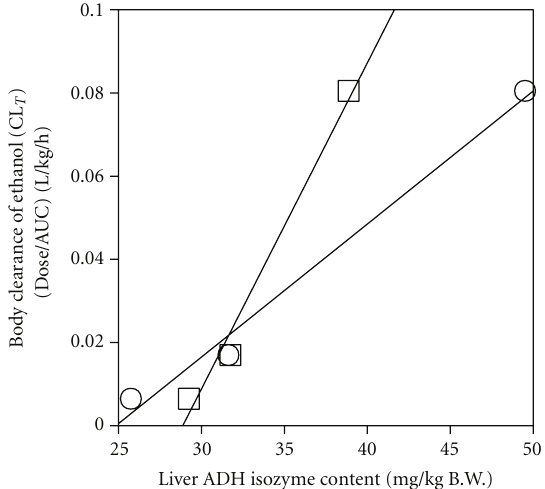
Figure 4: Correlation of liver ADH activity with ADH 1 ( (cid:2) ) and ADH 3 ( (cid:2) ) contents of liver. Each plot represents the value obtained from Figures 3(a) and 3(b).